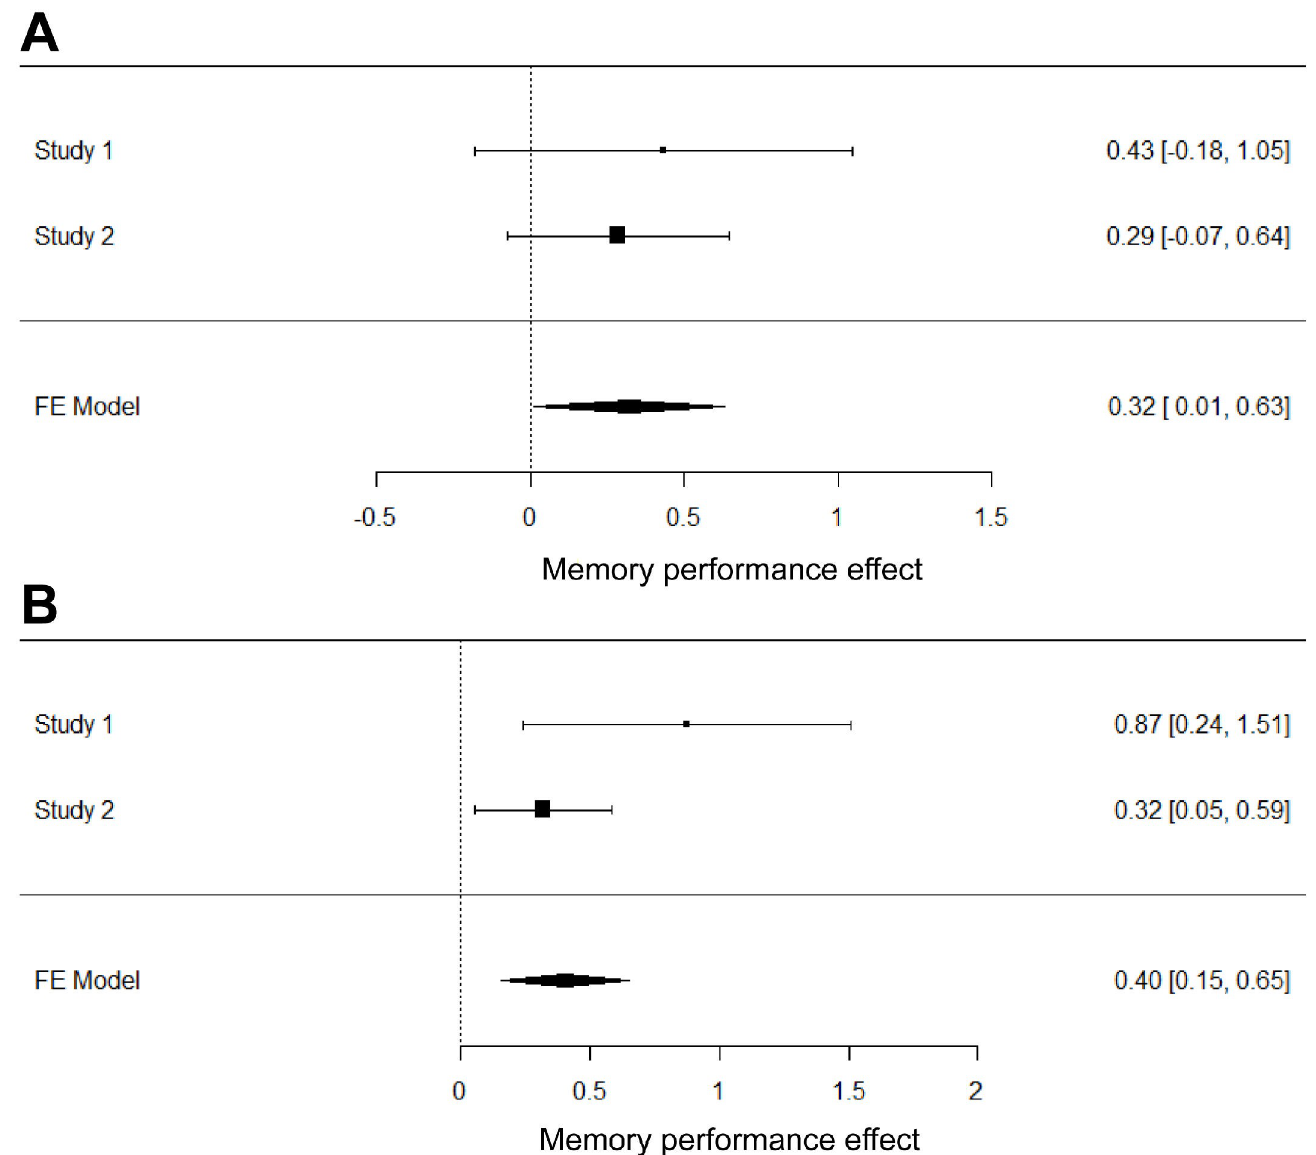
Fig 6. Meta-analysis of the behavioural results of the first and second experiment. Forest plots of the meta-analytically combined DLPFC effect for List 1 (A) and List 2 (B) words. Error bars represent 95% confidence intervals; effect sizes were calculated as Hedge’s g. The data and scripts used to generate this figure can be found at https://osf.io/dyxjv/. DLPFC, dorsolateral prefrontal cortex; FE AU : PleasedefineFEinFig 6 abbreviationlistifthisindeedisanabbreviation : , fixed